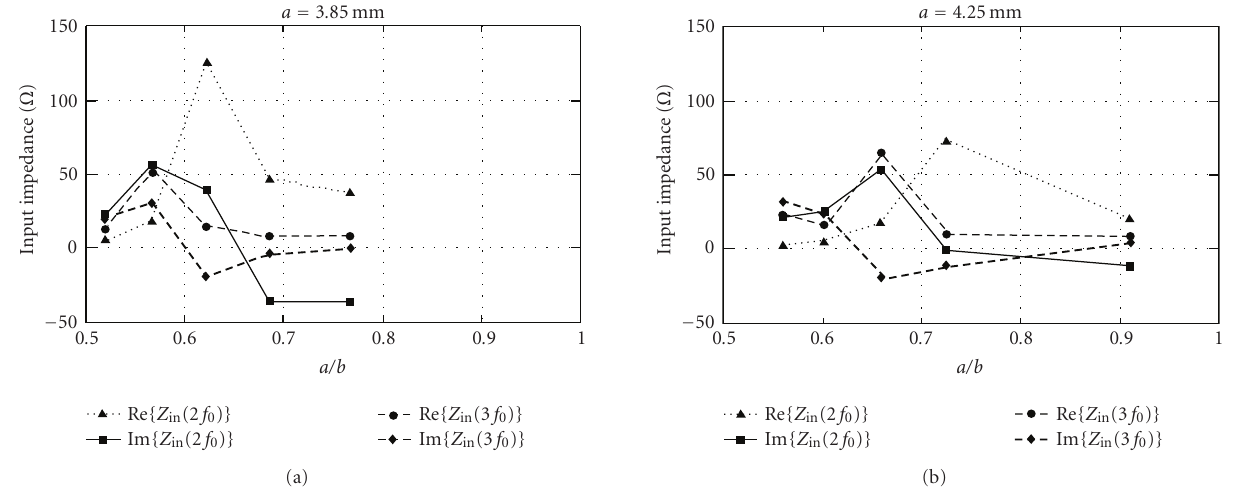
Figure 4: Real and imaginary values of the DRA input impedance at the second and third harmonic frequencies versus length-to-height ratio, for two values of the resonator length: (a) a = 3 . 85 mm and (b) a = 4 . 25 mm.